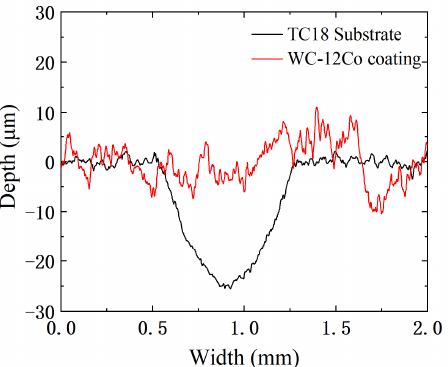
Figure 16. Abrasion contour lines of the TC18 substrate and the WC-12Co coating.